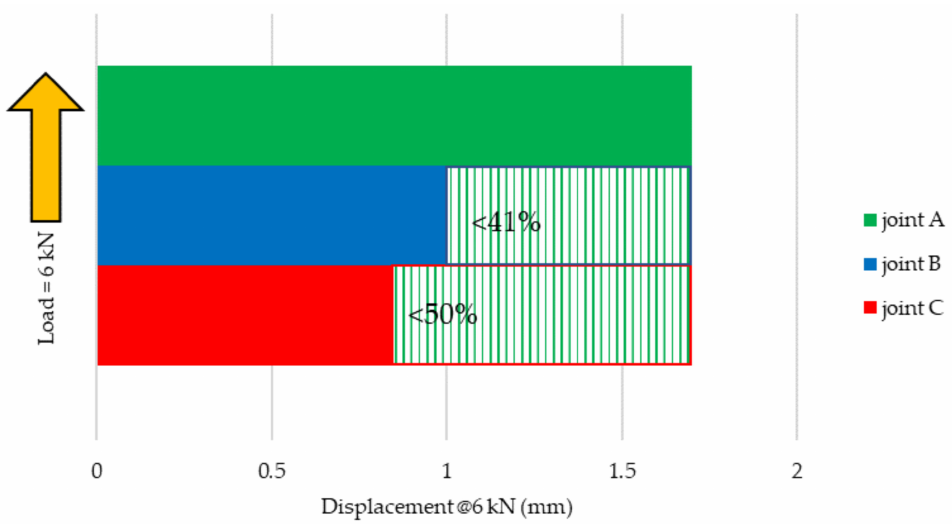
Figure 39. Comparative displacements @ same Load = 6 kN.